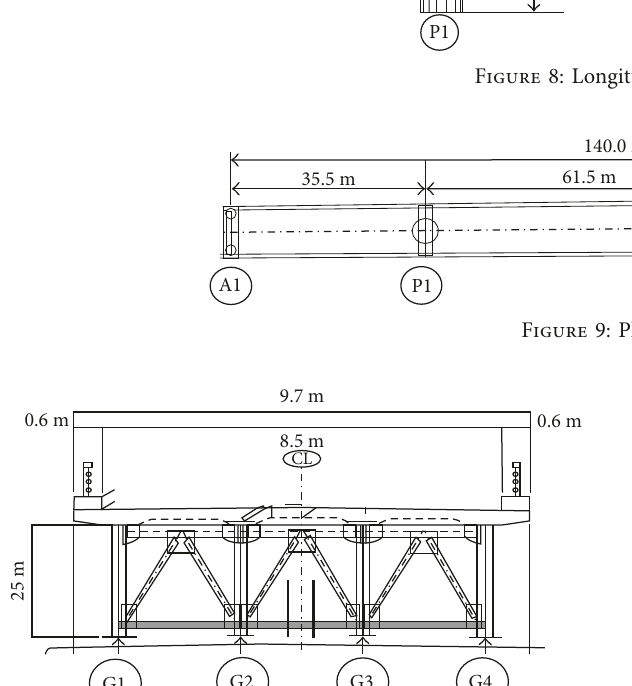
Figure 10: Cross section of the superstructure.